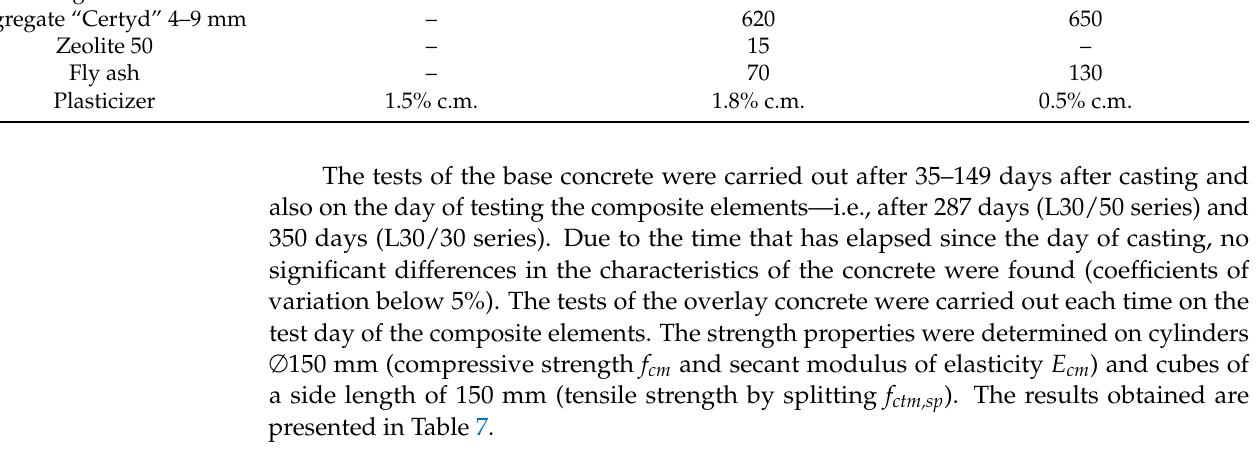
Table 7. Properties of hardened